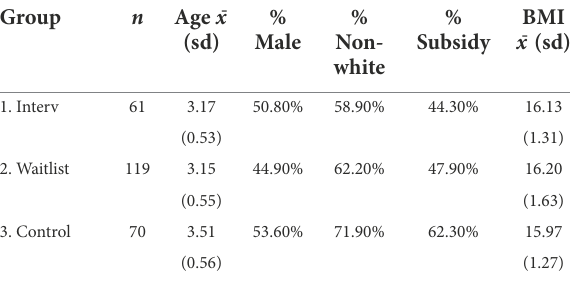
TABLE 3 COLEAFS randomized group characteristics at baseline, by intervention (I), waitlist (delayed intervention) (W), and control centers